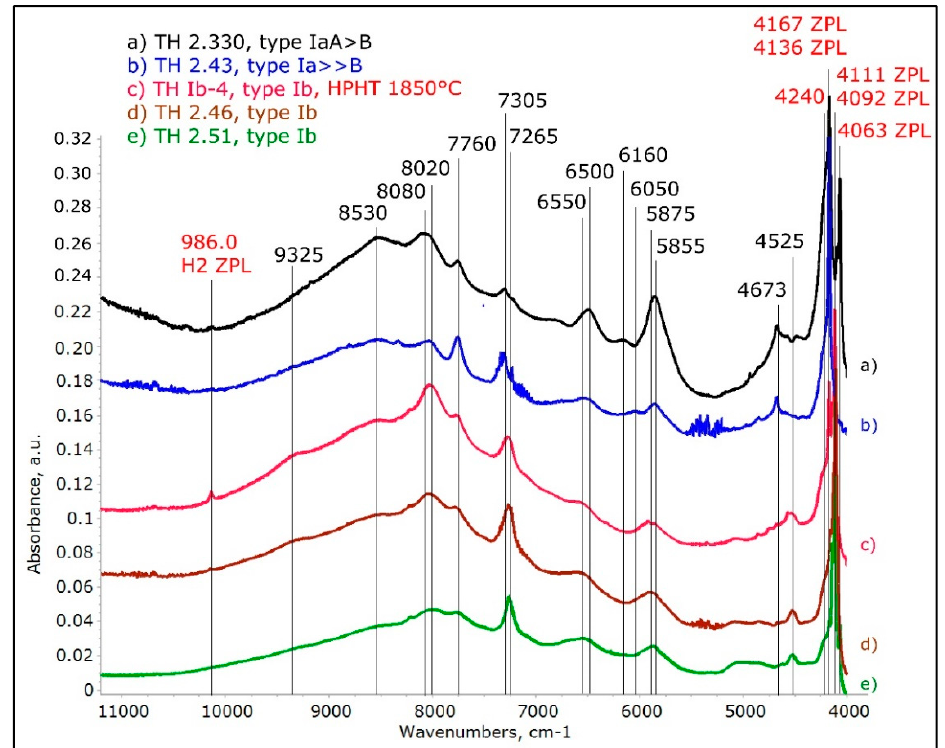
Figure 9. The NIR spectra of the different AC absorptions recorded with the samples at 77 K. The spectra confirm which ones of the absorptions are ZPL’s and which ones are not, and the significant sharpening and splitting of the absorptions reveal much more details about the ACs than the spectra at room temperature. The spectra were shifted vertically for clarity. Table 2. The different AC ZPLs and tentative details of their associated structure and spectral features. ZPL